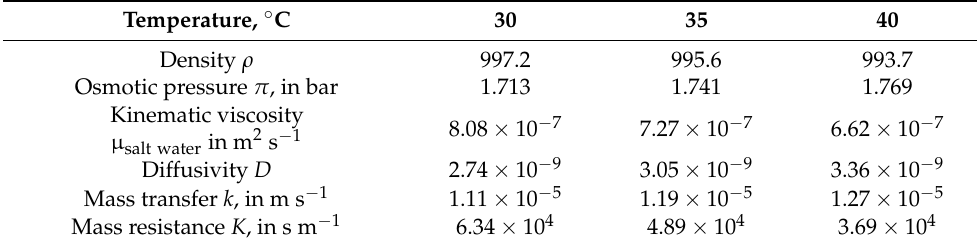
Table 3. Characteristics of the 2 g L − 1 NaCl solution at different